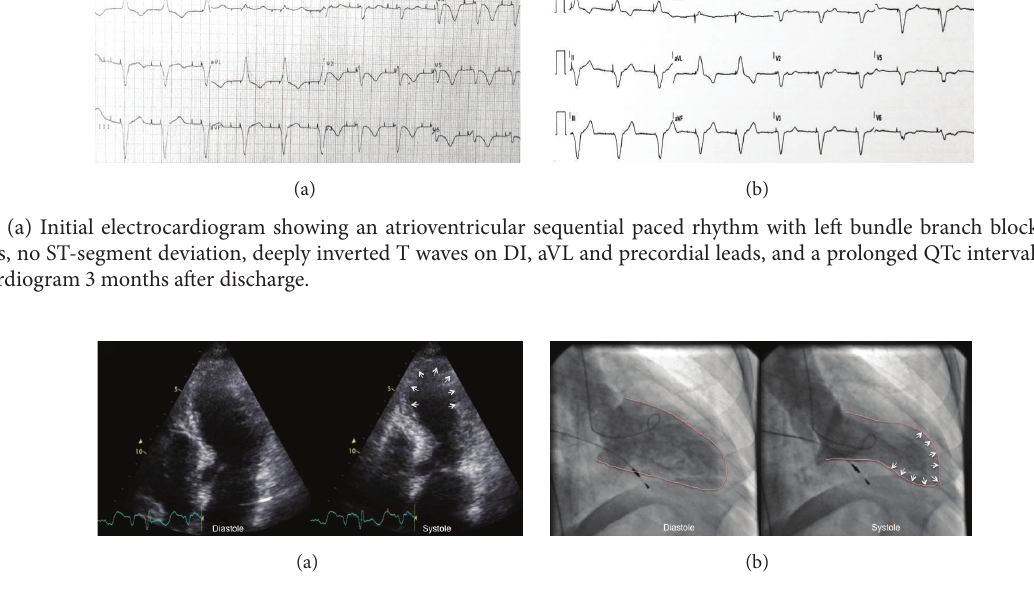
Figure 2: (a) Transthoracic echocardiography (apical four-chamber view) during the initial admission, demonstrating apical ballooning (white arrows). (b) Left ventriculography images in diastole and systole, showing typical type of takotsubo cardiomyopathy with apical ballooning, dyskinesia (white arrows), and left ventricle basal